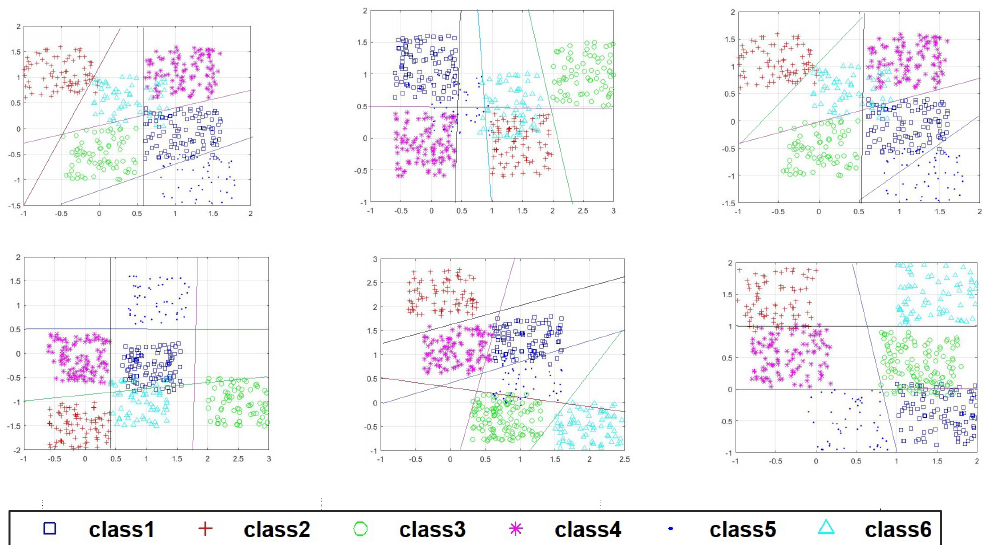
Figure 5. An adapted MLP classifier using Softmax based gradient descent classification features using no data augmentation (first row) and data augmentation (second row), where x − axis is training vectors, containing the number of samples and the number of features, and y − axis is the number of samples to plot decision